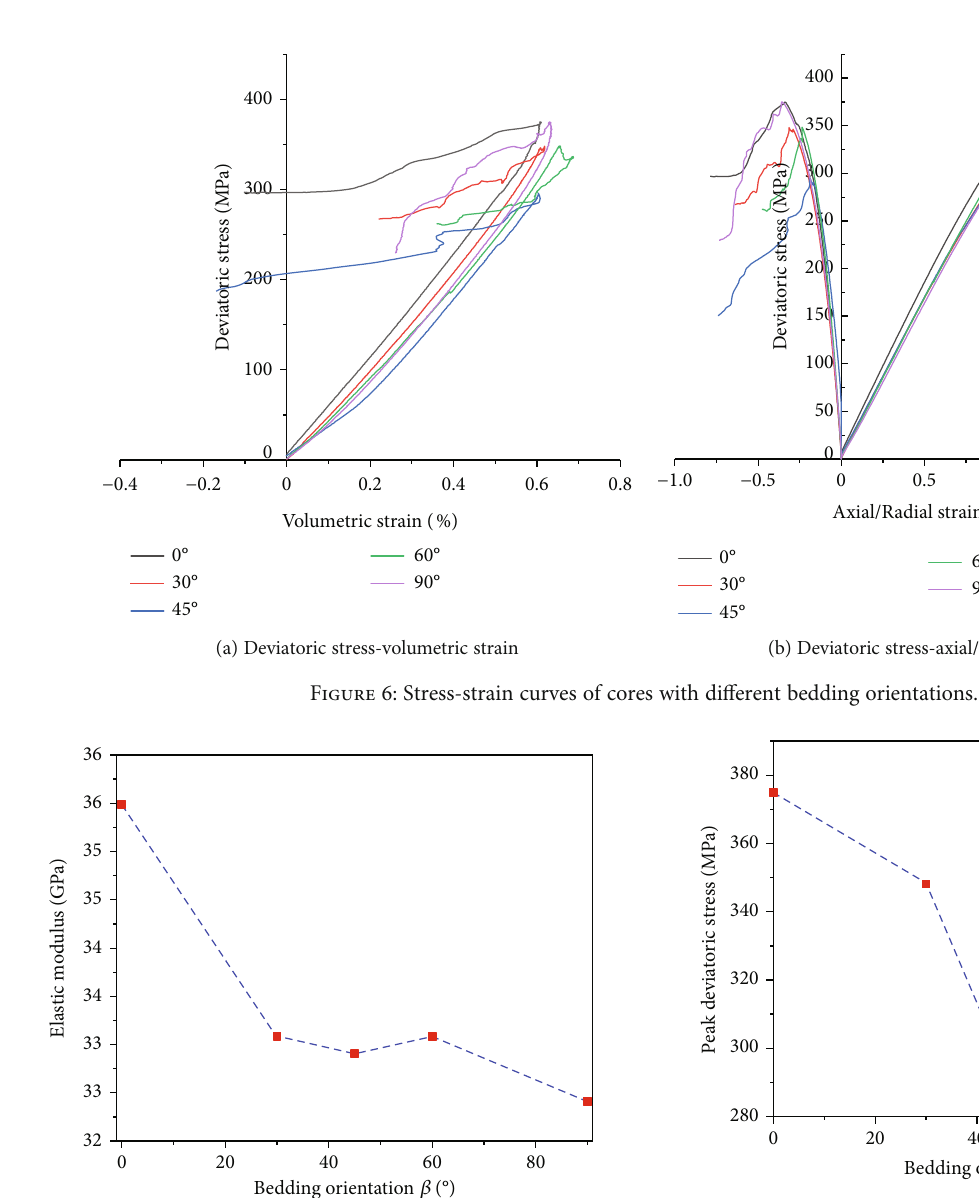
Figure 8: Variation of peak strength over β